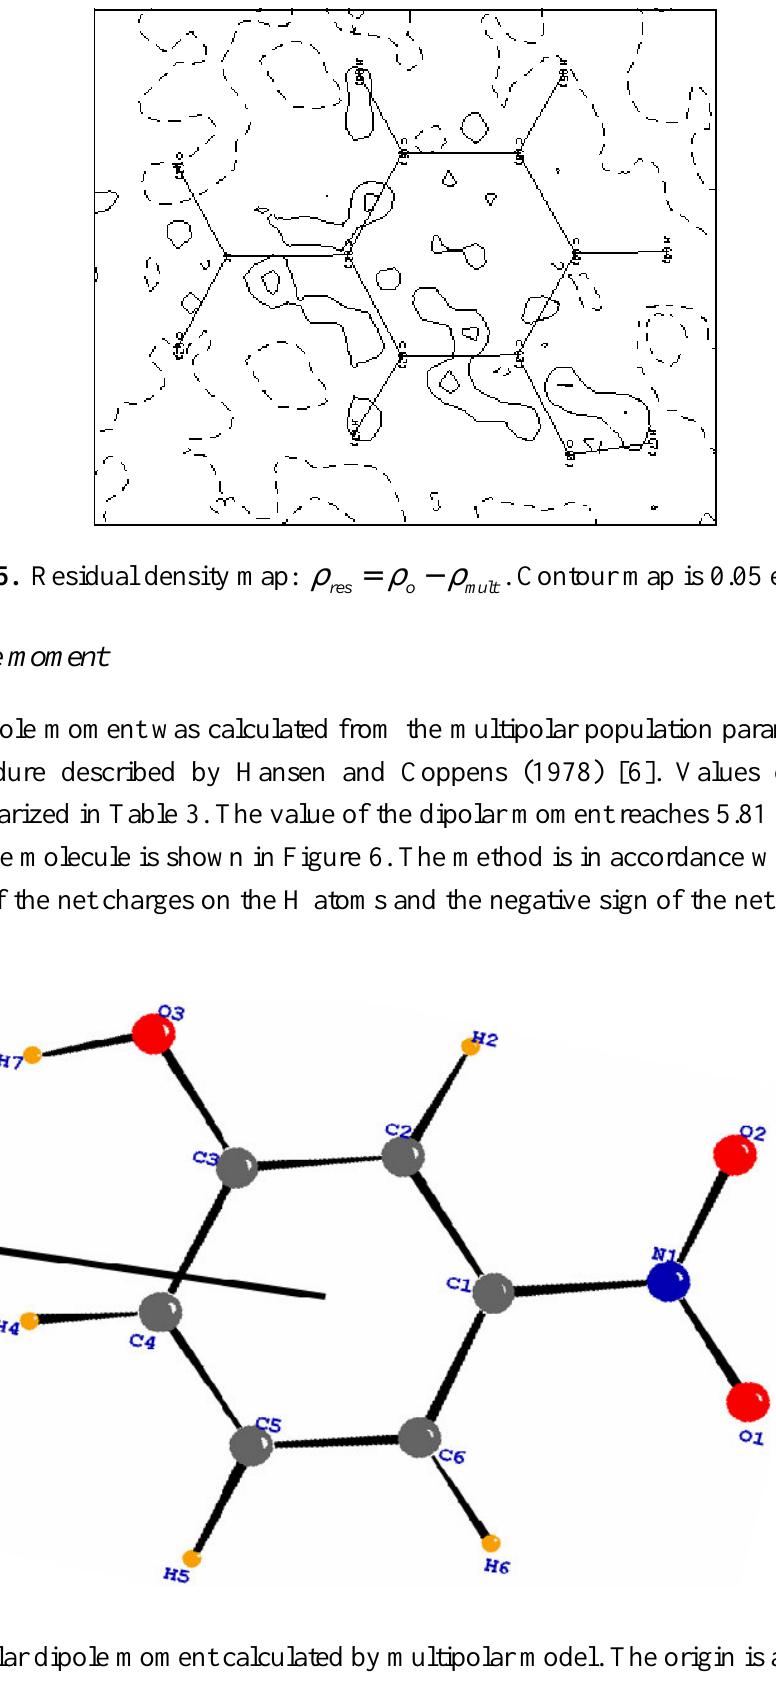
Figure 6. Molecular dipole moment calculated by multipolar model. The origin is at the center of mass of the